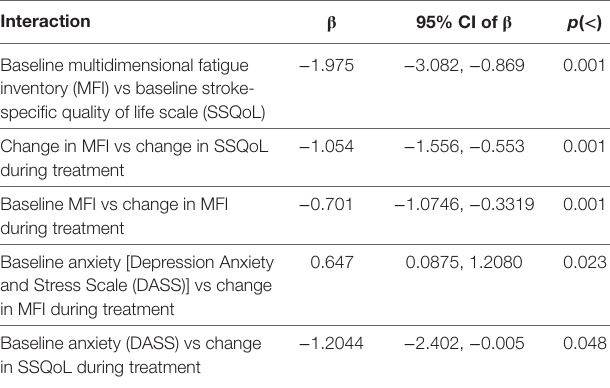
taBLe 1 | Interactions between baseline scores and treatment effects for the 6-week treatment period tested in the original modafinil in debilitating fatigue after stroke trial.